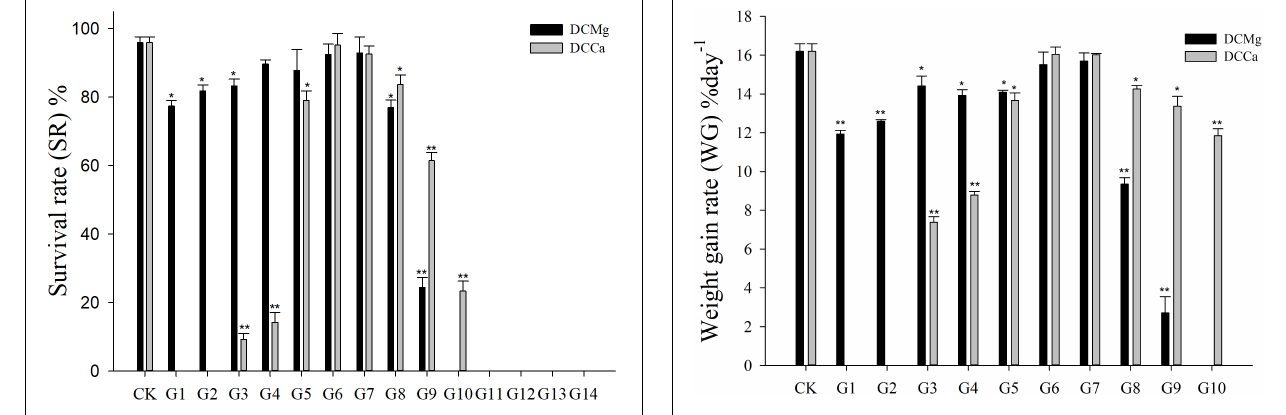
FIGURE 3 | Daily weight gain rate of JSCs under long-term stress with different Ca 2 + and Mg 2 + concentrations. Bars (mean ± SE, n = 3) with an asterisk denote a significant difference ( ∗ P < 0.05, ∗∗ P < 0.001) between the test groups (G1–G10) and CK.